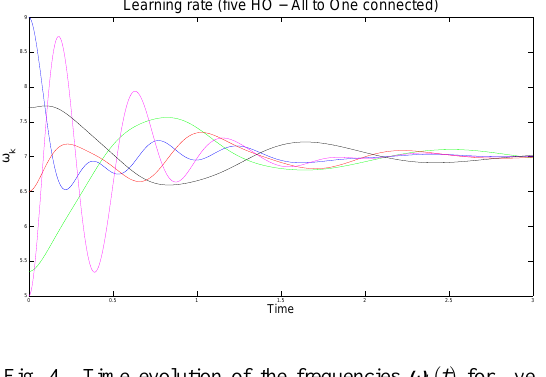
Fig. 4. Time evolution of the frequencies w k ( t ) for five Hopf oscillators with K 1 = 1, K 2 = 1 , K 3 = 5 , K 4 = 5, 2 4 w w w w K 1 1 ( 0 ) = 9, 2 ( 0 ) = 5 . 35, 3 ( 0 ) = 6 . 5, 4 ( 0 ) = 5, 5 = 3 w 5 ( 0 ) = 7 . 7 and with network topology “All to One”. The consensual frequency, given by Eq.(10), is w c =